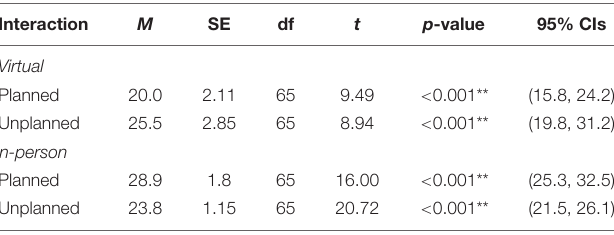
TABLE 7 | Simple main effects on meaningfulness for planning by